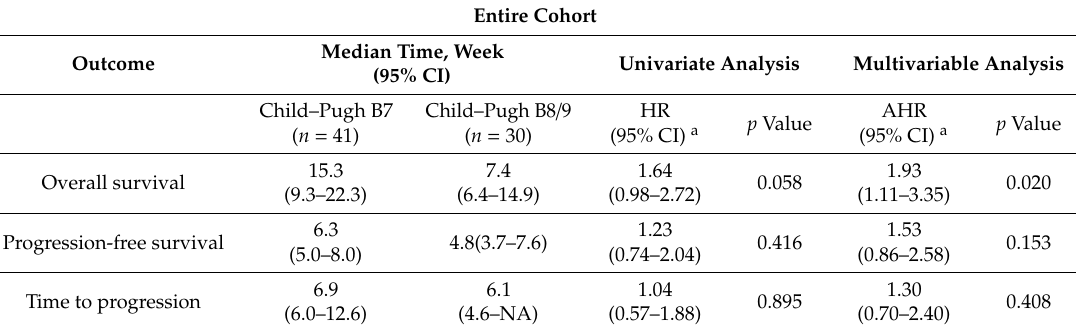
Table 5. Survival outcomes of Child–Pugh B